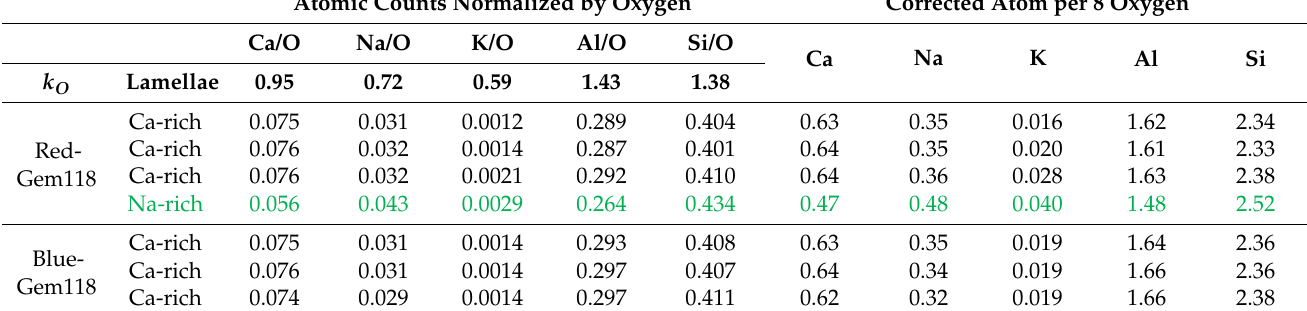
Table 3. Normalized atomic counts and corrected atom per formula of sample Gem118 from the atom probe tomography data. The k factors are calculated based on the Ca-rich lamellae from the EDS mapping. The composition of the Na-rich lamella is highlighted in green.